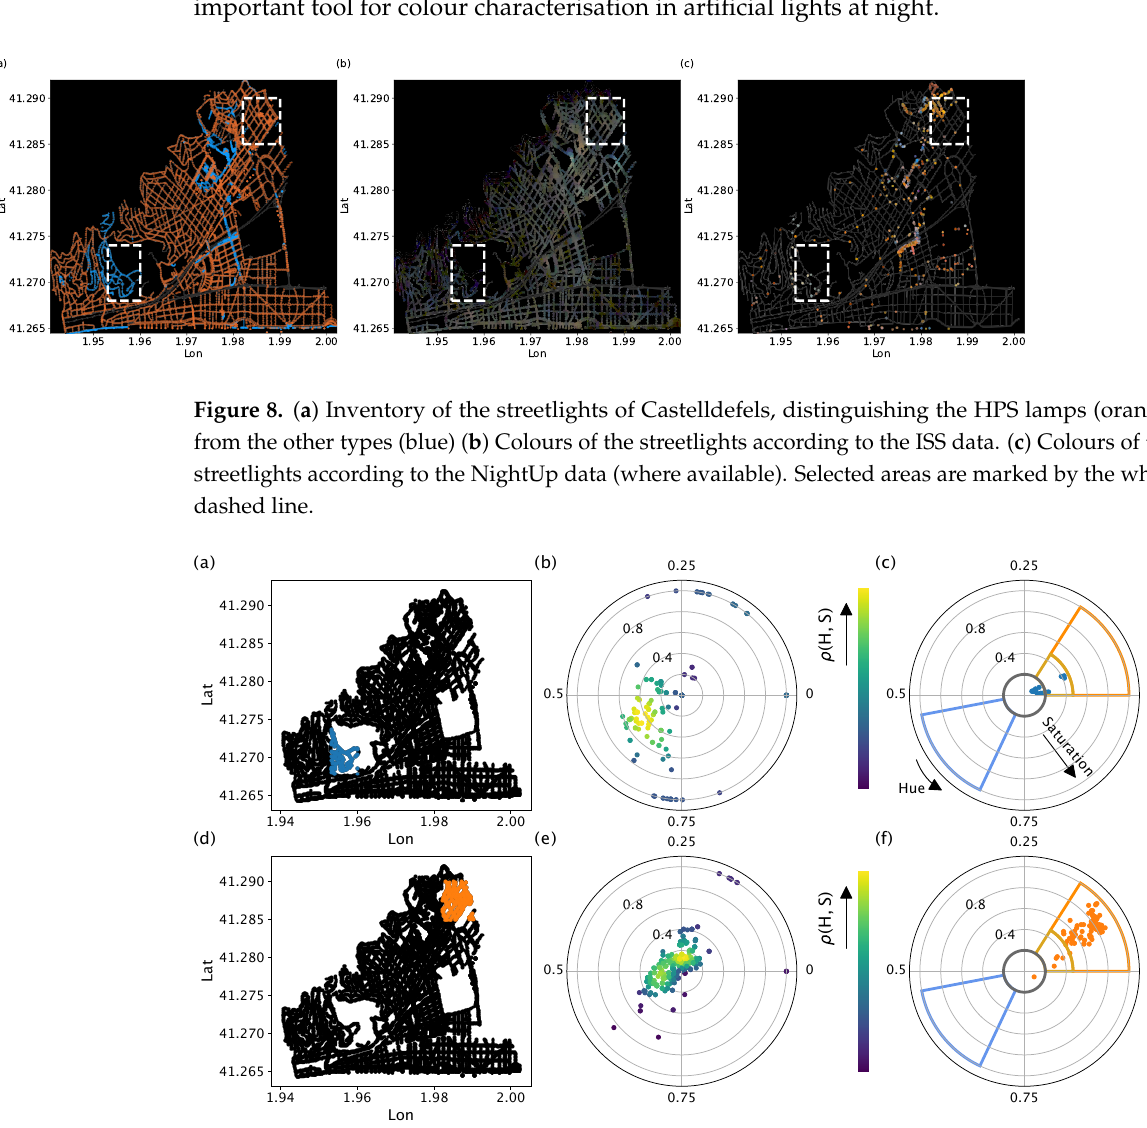
Figure 9. ( Top row ): Comparison between the colours from the ISS ( b ) and from NightUp ( c ) for a region labelled by the city council of Casteldefells as LEDs ( a ). ( Bottom row ): Comparison between the colours from the ISS ( e ) and from NightUp ( f ) for a region labelled by the city council of Castelde- fells as HPS ( d ). The colour of each point in ( b , e ) represent its kernel density estimation value with respect to a Gaussian kernel ρ ( H , S ) (see main text for